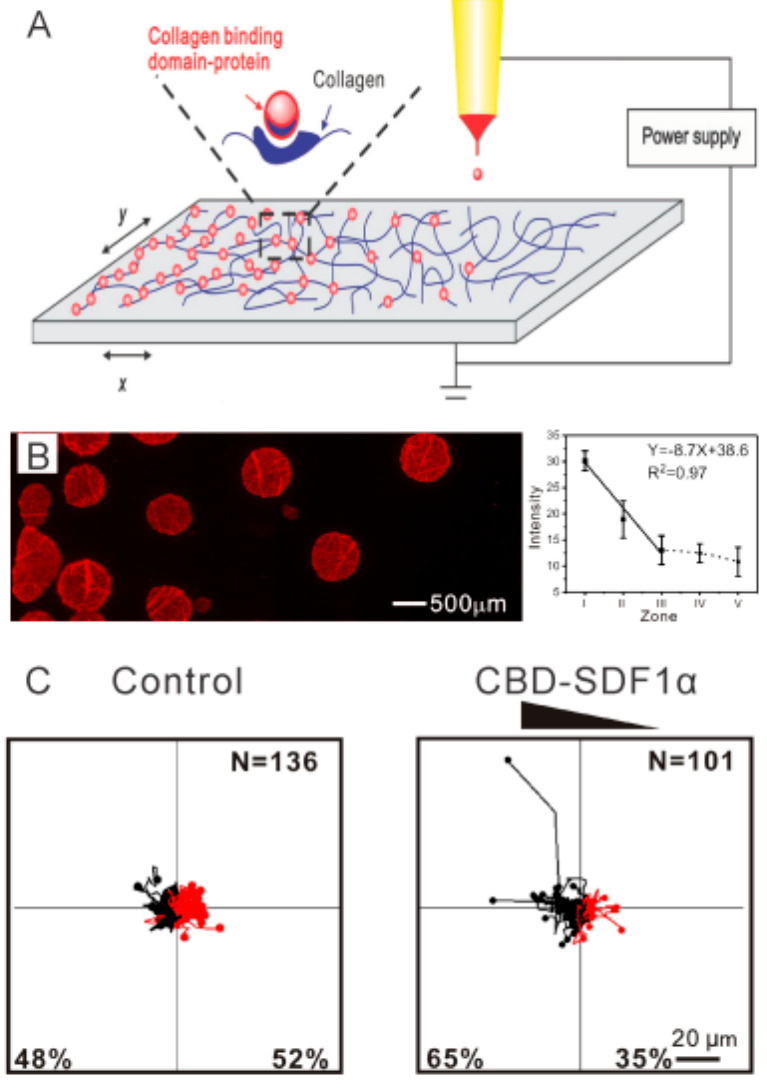
Figure 6. CBD-SDF1 α gradients produced by inkjet printing on electrospun nanofibers. ( A ) Schematic illustration of inkjet printing. ( B ) CBD-SDF1 α gradient patterns on collagen nanofibers. ( C ) A CBD-SDF1 α gradient promoted NSC migration. Reprinted from Reference [51].